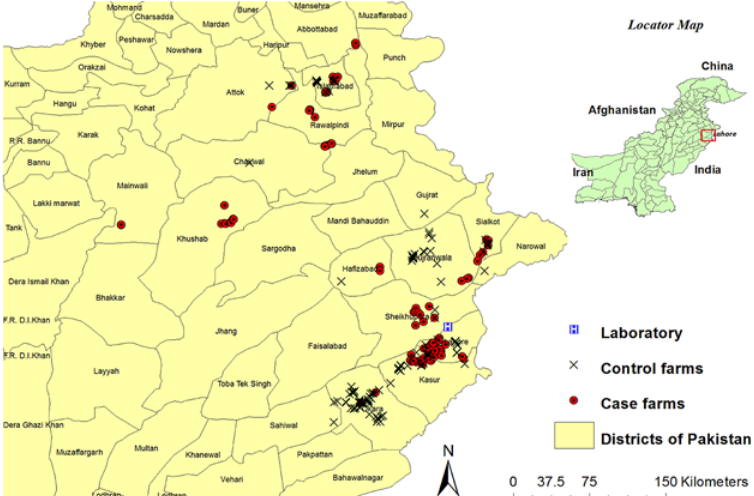
Fig 1. Spatial distribution of case and control farms in different districts of Pakistan, sampled between May 2009 and January 2010.